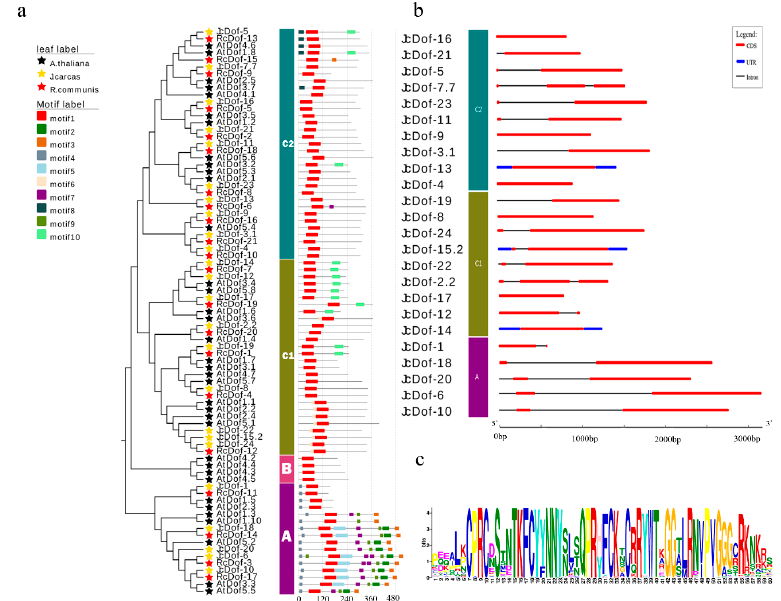
Figure 3. JcDof gene structures and conserved motifs in JcDof proteins. ( a ) The distribution of 10 conserved motifs in Dof proteins; ( b ) Gene structures of JcDof genes. CDS, UTR and introns were depicted by filled red boxes, blue boxes, and single black lines; and ( c ) Motif-1, corresponding to theCX2CX21CX2C single zinc-finger structure. The detailed motif’s sequences are shown in Figure S1 and Table S4.